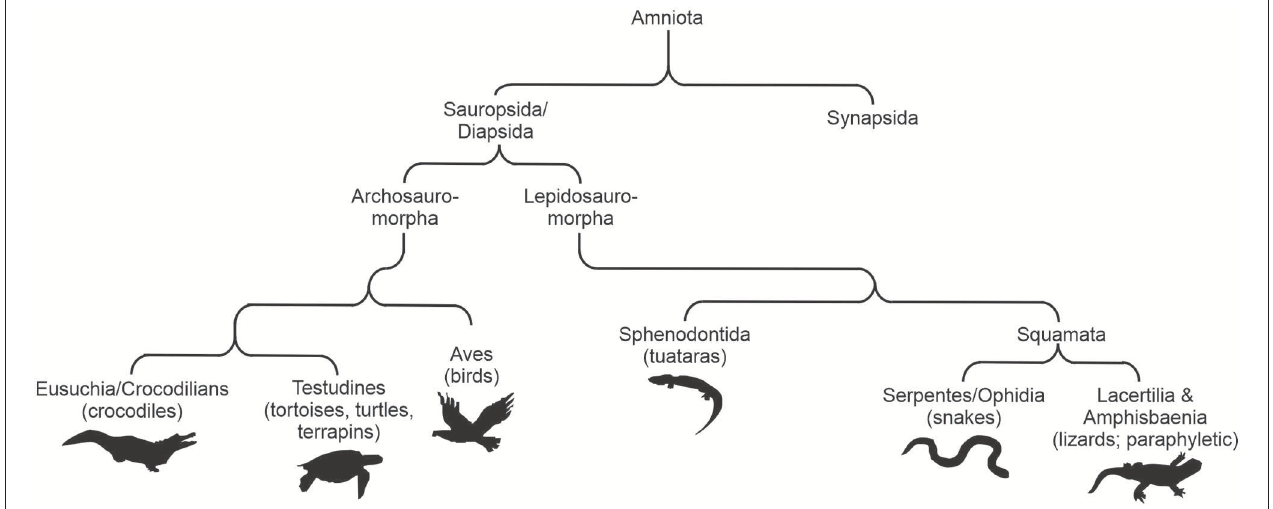
FIGURE 1 | A basic summary cladogram showing the relationships of the amniotes. Modified from Davies et al. (2012).